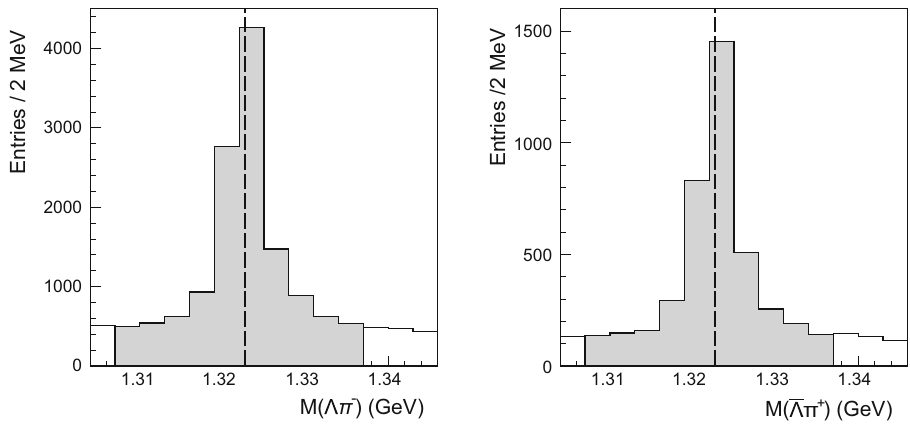
+ ) candidates are shown in the left panel ( right panel ). Filled areas indicate the mass